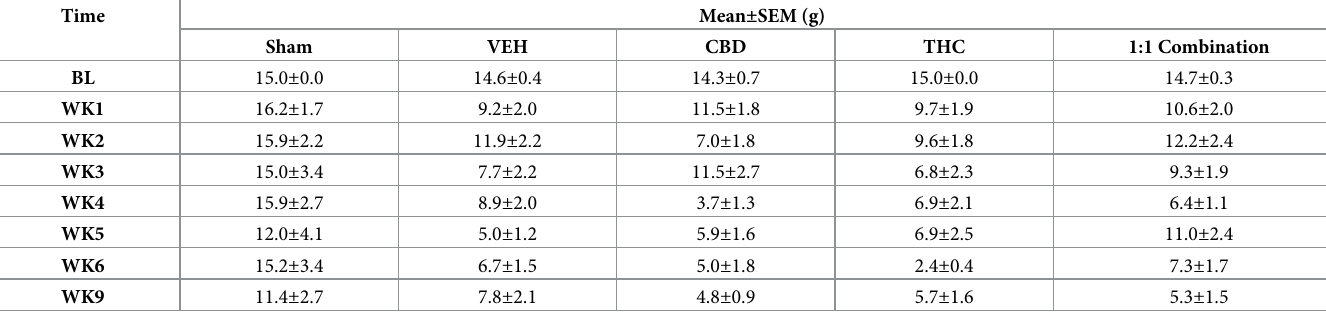
Values with an asterisk ( � ) represent statistical differences between the VEH group and each of the individual treatment regimens at each time point over the course of the 9 week experiment, as determined by a 2-way ANOVA with a Bonferroni multiple comparison test ( � P < 0.05, �� P < 0.01, ��� P < 0.001, and ���� P <